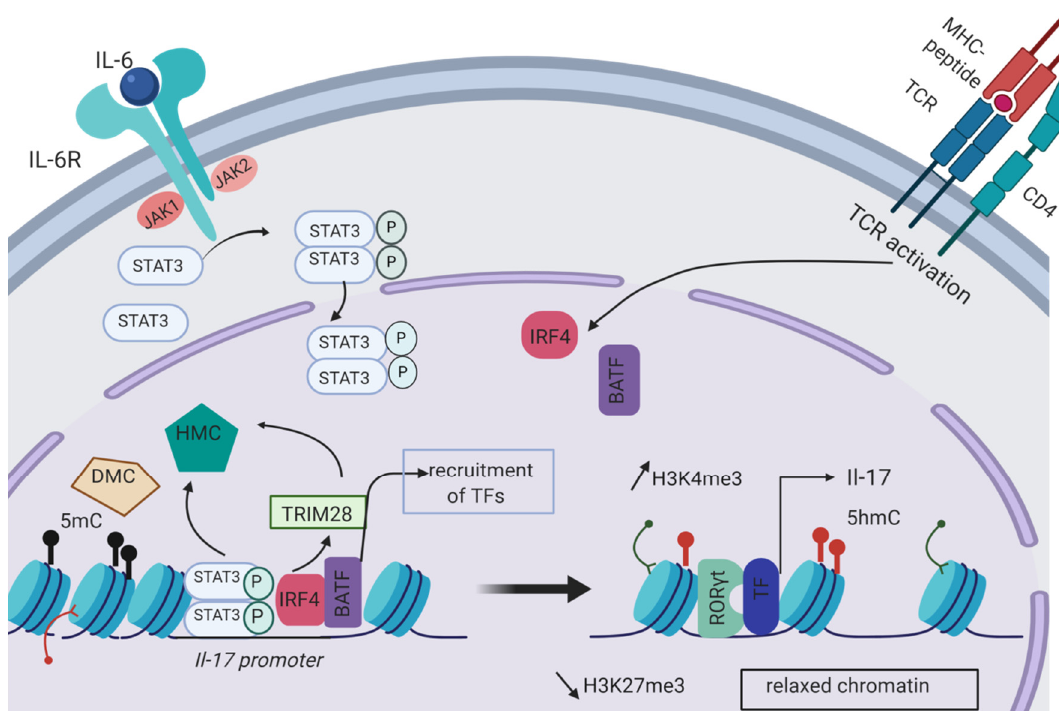
Figure 1. Epigenetic regulation of Il-17 expression occurring during Th17 cell differentiation. The transcription factors IRF4 and BATF are induced upon TCR activation in CD4 T cells. IL-6 promotes STAT3 phosphorylation and dimerization through its receptor (IL-6R). Following nuclear translocation, STAT3, IRF4 and BATF bind to the Il-17 promoter. Histone modification complexes (HMCs) including HMTs or HATs as well as DNA modification complexes (DMCs) like DNMTs are then directly recruited at the Il-17 promoter by STAT3 or indirectly through the epigenetic regulator TRIM28. HMCs and DMCs are responsible for the formation of permissive histone marks like H3K4me3 or demethylation of CpG islands with the formation of 5-hydroxymethylcytosine (5hmC). On the contrary, DNA methylation (5mC) and repressive histone marks (H3K27me3) are decreased at the Il-17 locus thus allowing chromatin remodeling and accessibility of the Il-17 promoter to other transcription factors. Among the transcription factors required for Il-17 expression, ROR γ t is recruited to the Il-17 promoter by TRIM28. Created with BioRender.com.